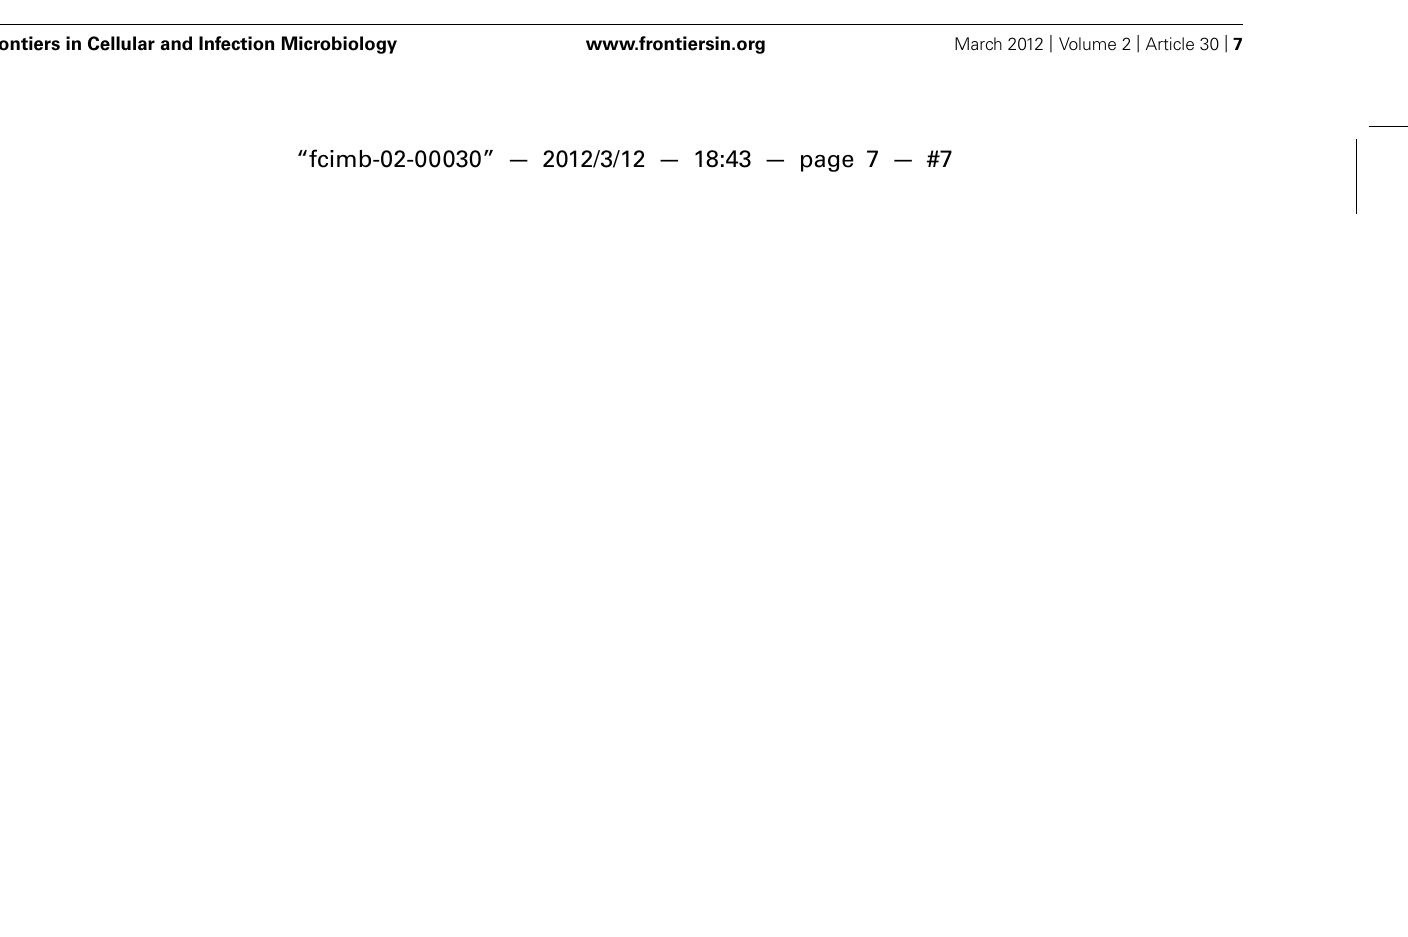
ceca). Each dot represents the load of C. jejuni in the cecum of an individual chick.The geometric mean of the bacterial loads from each set of chicks is denoted by the horizontal bar.The line designates the detection limit of 2 × 10 2 CFU/g of ceca. Statistical analysis was performed using the Mann–Whitney test (mean and P -value < 0.01). *Significant difference between the parental and pnp mutant